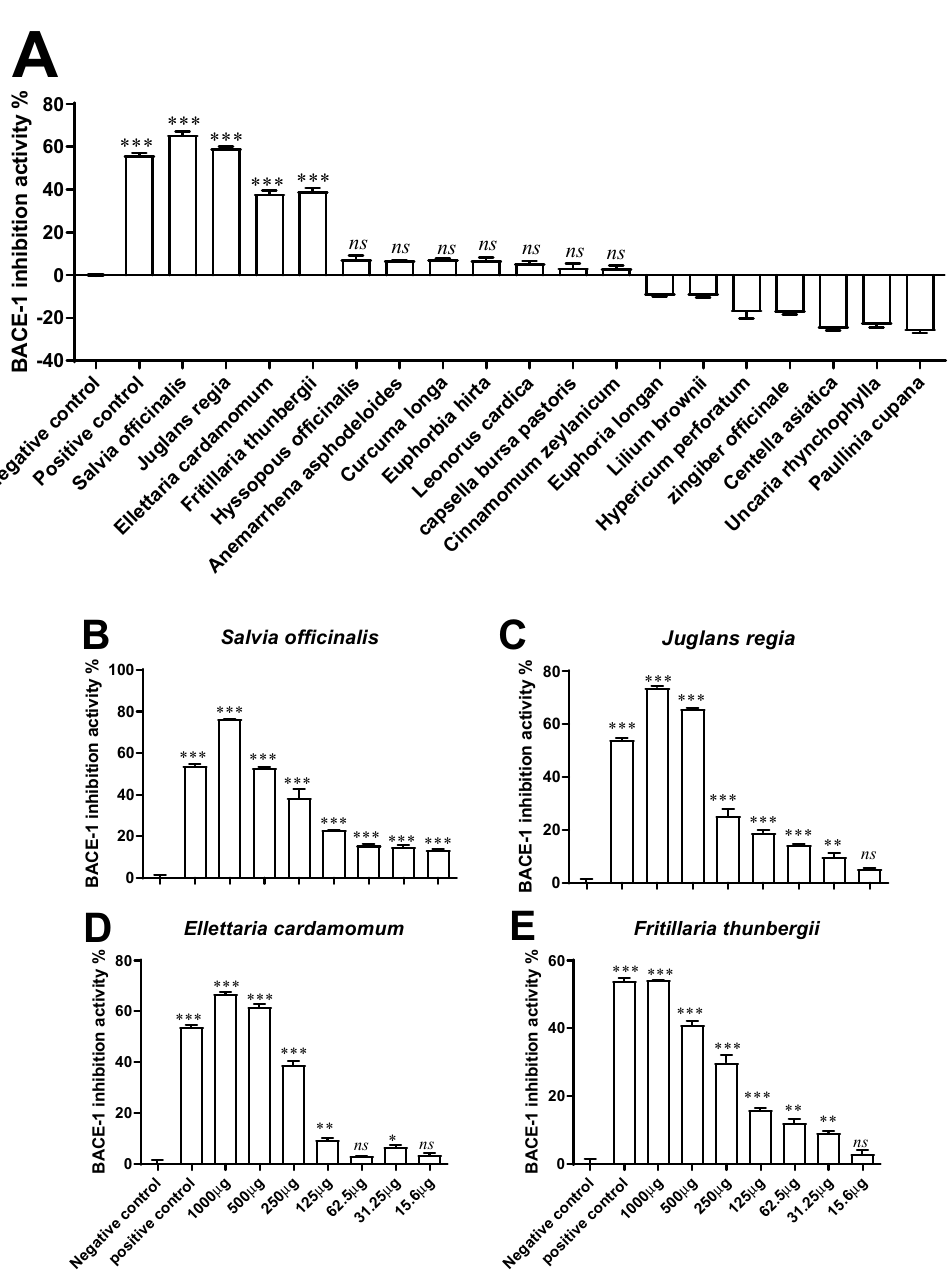
Figure 2. β -secretase (BACE-1) inhibitory activity of plant extracts. ( A ) Plant extract ( n = 18) concen- trations were initially screened at a concentration of 500 µ g/mL; ( B – E ) the concentration-dependent activities (15.6–1000 µ g/mL) were then determined for four selected phytoextracts, i.e., S. officinalis, J. regia, E. cardamomum , and F. thunbergii. The inhibitory activity was determined by using a stan- dardised BACE-1 Activity Detection Kit, with KF-14 (25 µ M) used as a positive control. * p < 0.05, ** p < 0.01, and *** p < 0.001 compared with negative control (vehicle control, i.e., 1% DMSO in ddH 2 O). ns (not significant).